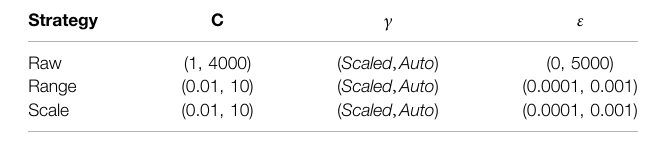
TABLE 3 | Hyper-parameters search space of